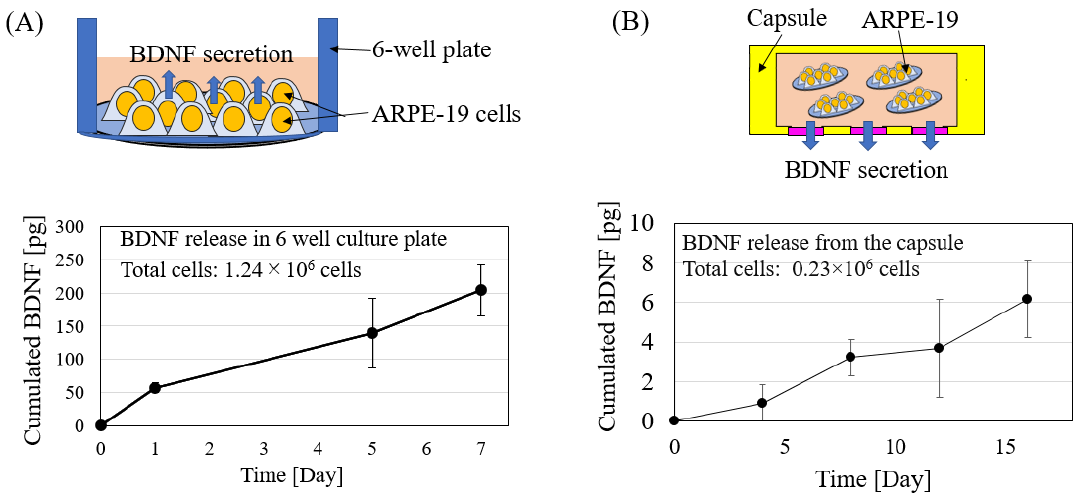
Figure 6. Total amount of BDNF collected from ARPE-19 cultured in ( A ) 6-well plate and ( B ) cell-encapsulated capsule. Image inserts show illustration of the experiment conducted. The error bars indicate standard deviation (n = 3 samples for each group).